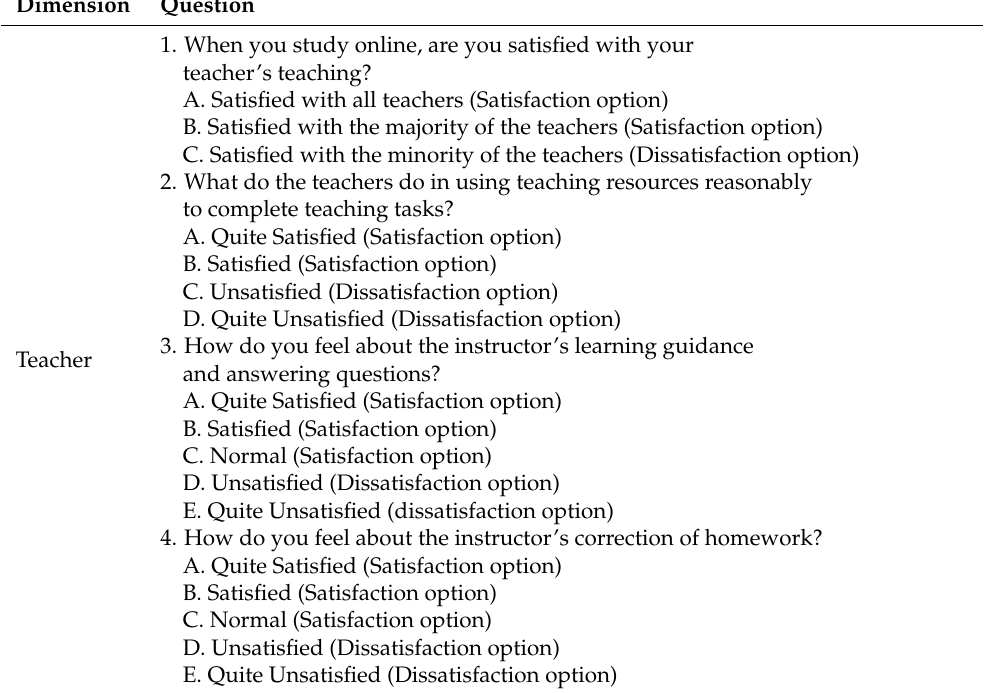
Table 1. Questionnaire